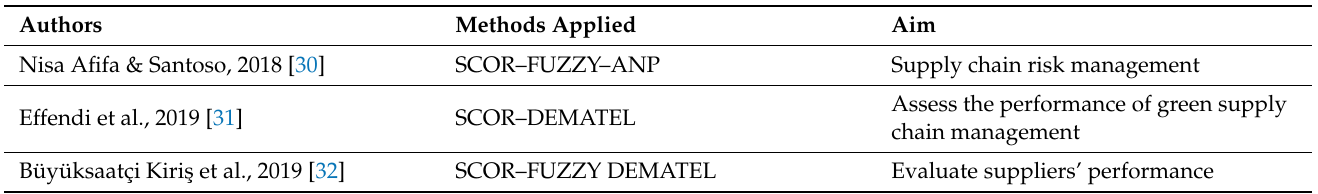
Table 1. Combinations of the SCOR model with multi-criteria techniques for studying supply chain